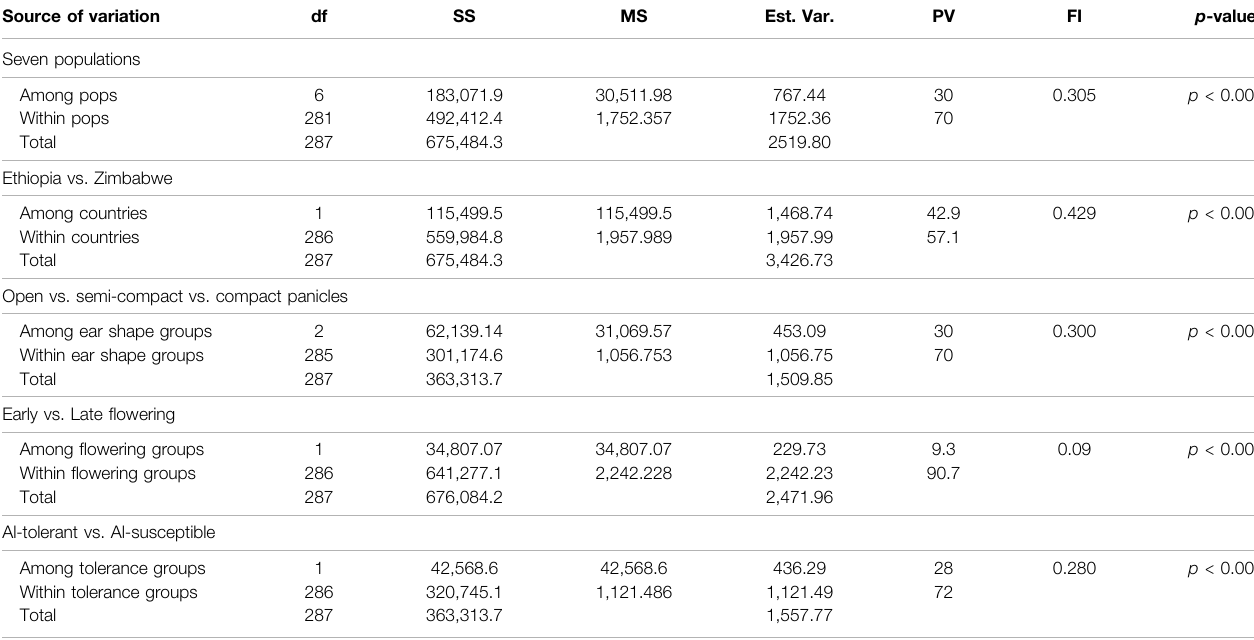
TABLE3| Analysisofmolecularvariance(AMOVA)ofdifferentgroupsformedfromthe288 fi ngermilletaccessionsbasedontheirgeographicorigin,countryoforigin,panicle type, days to fl owering, and aluminum tolerance using 5,226 SNP markers. Source of